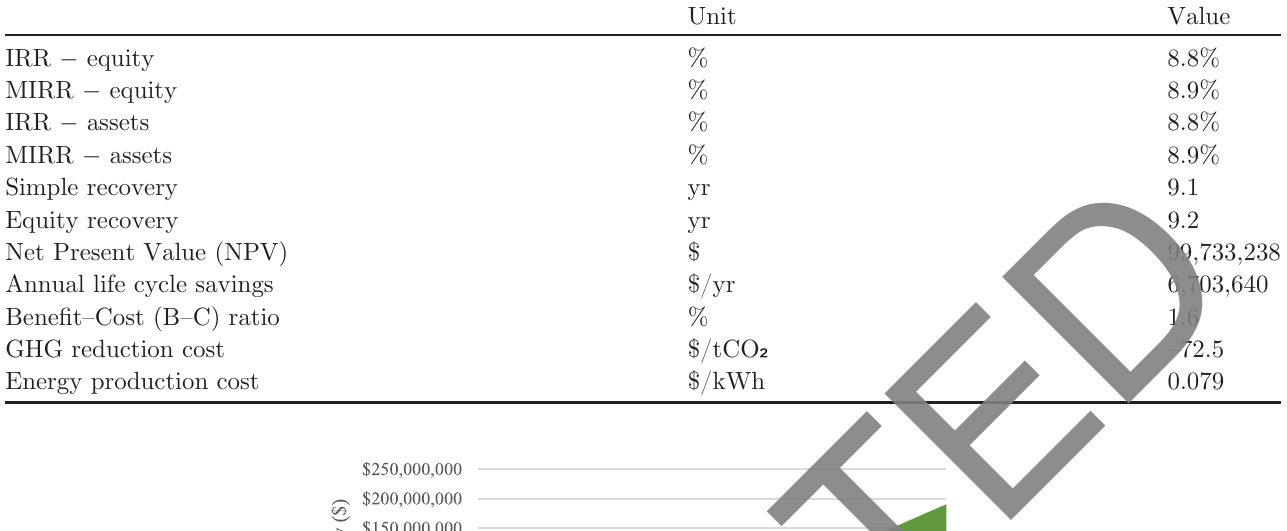
Fig. 13. Cumulative cash fl ow.